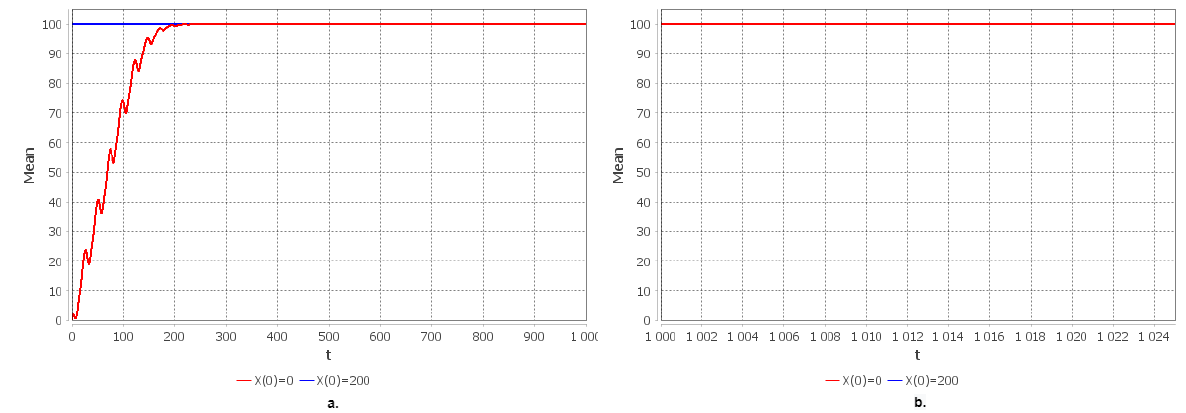
Figure 5. ( a ) The mean of applications served E ( t , k ) for t ∈ [ 0,1304 ] . ( b ) Approximation of the limiting mean of applications served E ( t , k ) for t ∈ [ 1304,1329 ] .